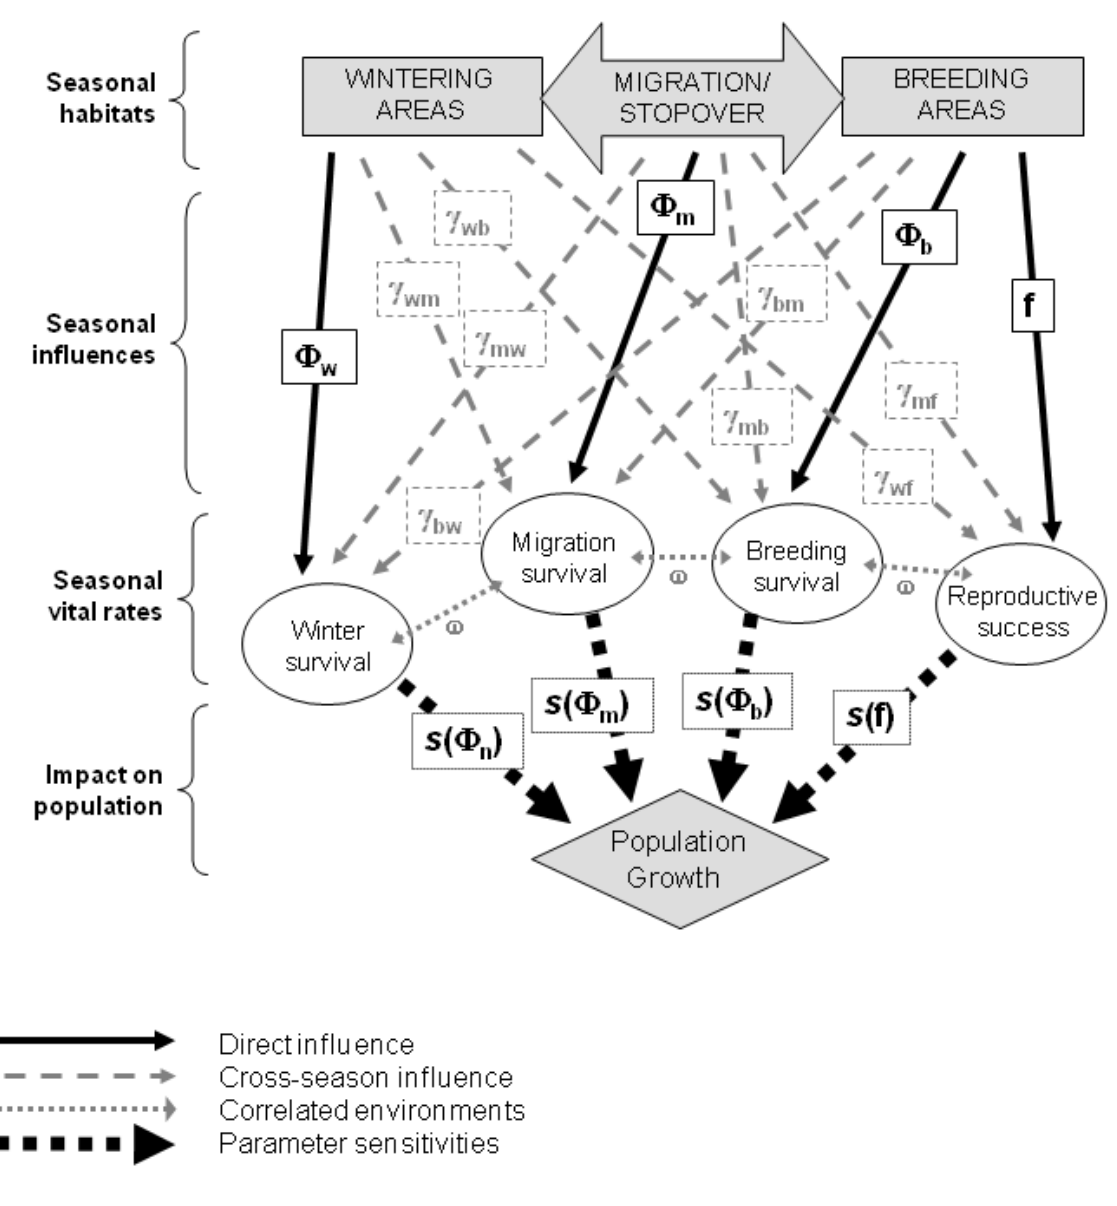
Fig. 2. Generalized schematic illustrating the influences of seasonal events on the population dynamics of seasonal migrants. Arrows represent direct seasonal fitness impacts (solid black arrows), cross- seasonal interactions (dashed grey arrows), covariation in seasonal environments (solid grey arrows), and sensitivities of population growth to seasonal vital rates (dotted black arrows). Note that terminology applies generally to avian migrants, but concepts extend to all seasonal migrants (e.g., “winter” refers to any primarily stationary nonbreeding season). See Table 2 for definitions and literature examples of each seasonal influence and their links to population